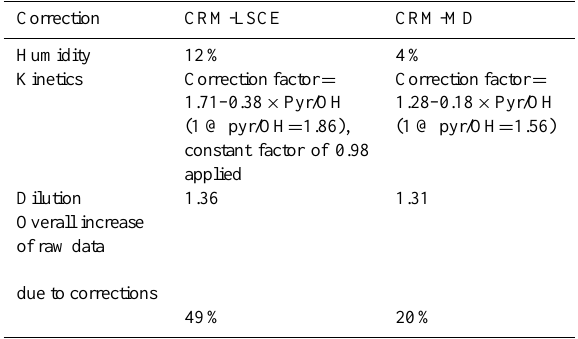
Table 2. Summary of correction stages applied to raw reactivity data for CRM-LSCE and CRM-MD. Correction coefficients are ob- tained from experiments as described in the section data analysis.